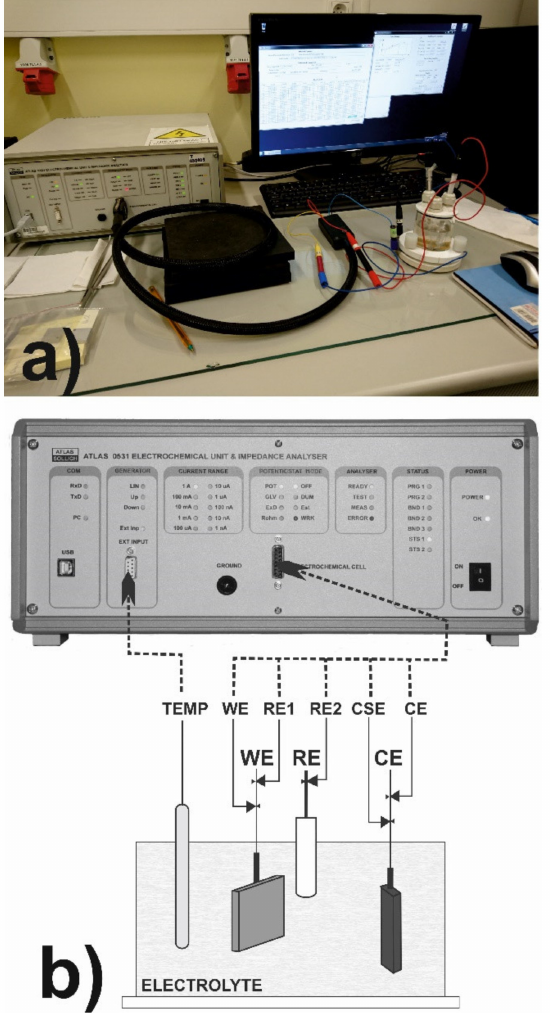
Figure 4. ATLAS 0531 electrochemical unit and impedance analyzer ( a ) and the scheme of 3-terminals cell connections ( b ); WE—working electrode; CE—counter electrode; RE—reference